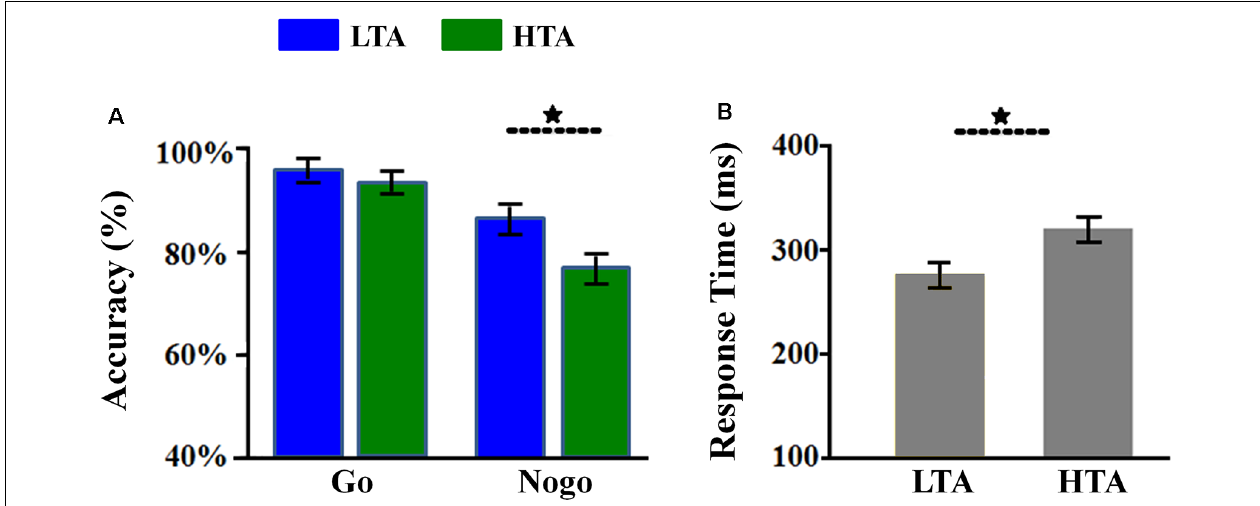
FIGURE 2 | Behavioral results. (A) The Go accuracy and NoGo accuracy in the two groups. (B) The overall response time (RT) in the two groups. Bars represent standard error of the mean. LTA, the low-trait anxiety group; HTA, the high-trait anxiety group. * p < 0.05.